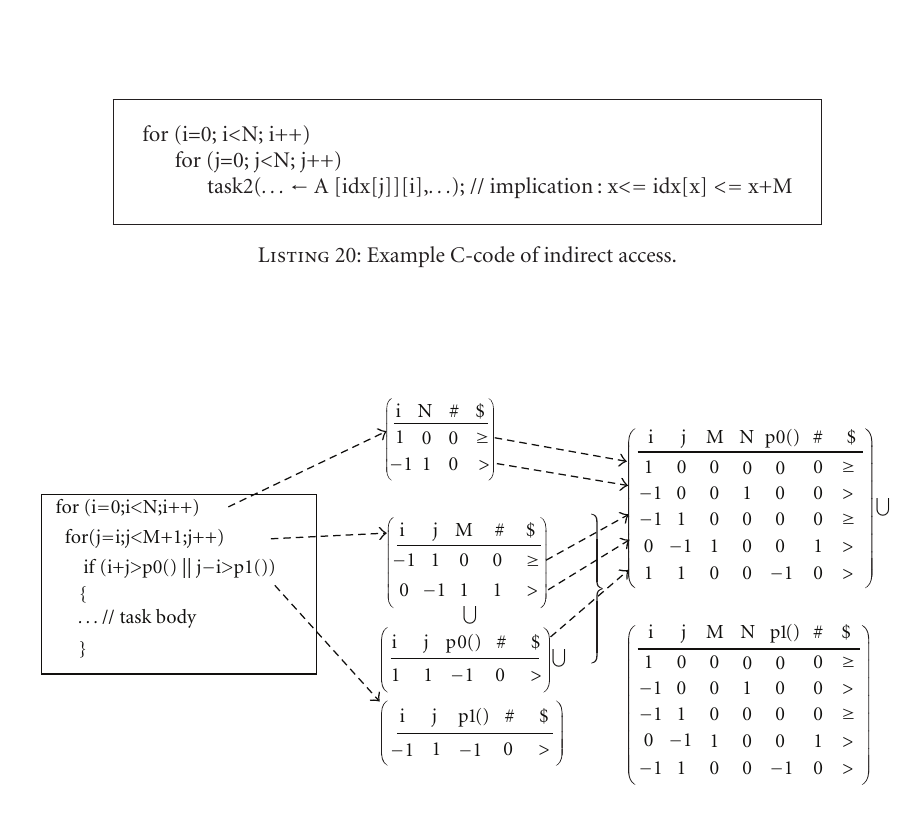
Figure 13: Polyhedral representation for iterator